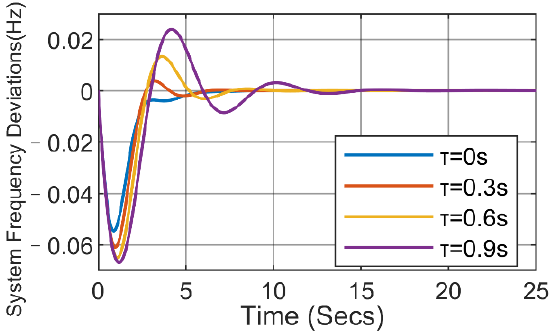
Figure 7. Frequency response of EVs under different communication delays.